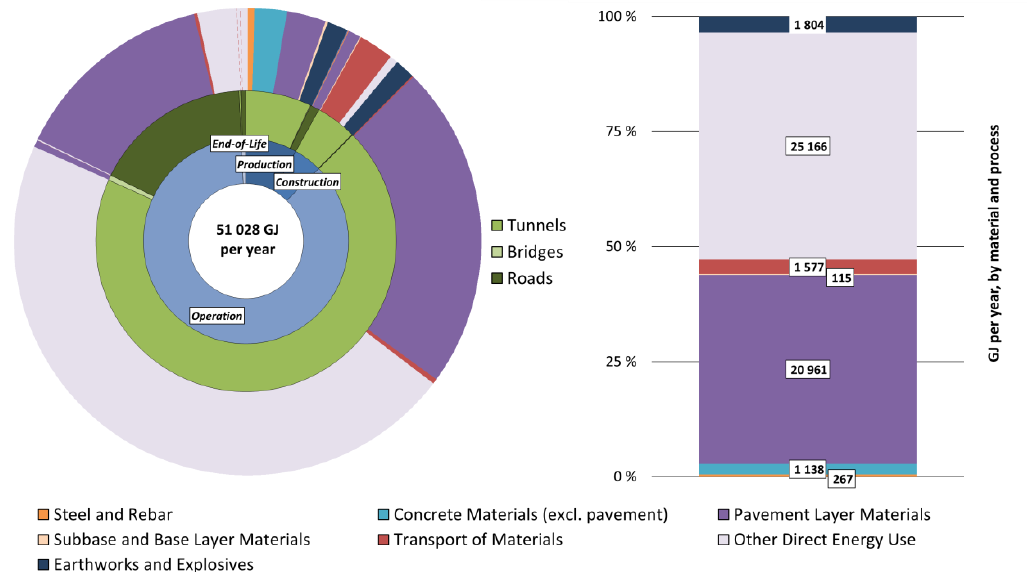
Figure 6. Contribution analysis for cumulative energy demand (CED) for Alternative 1 The CED results for Alternative 1 are also dominated by tunnels, in the form of “other direct energy use”. This energy use comes from the very high electricity demand of the ventilation and lighting systems to be used in a new underwater tunnel (23,448 GJ). Interestingly, the large operational energy of tunnels does not lead to high GHG emissions due to the very low carbon intensity (20 g CO 2 -eq/kWh) of the Norwegian electricity supply, which is more or less hydropower based. Replacement of pavement layer materials in tunnels (11,393 GJ) and roads (7,138 GJ) during the operation stage are the next two large contributors to CED in Alternative 1.